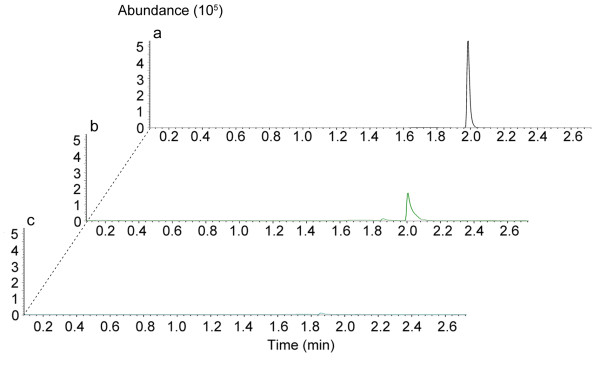
Metabolic flux analysis of C. acetobutylicum
Rh8(psADH) and C. acetobutylicum
Rh8(pIMP1). The detailed reaction formula used for
flux analysis was shown in Appendix A.